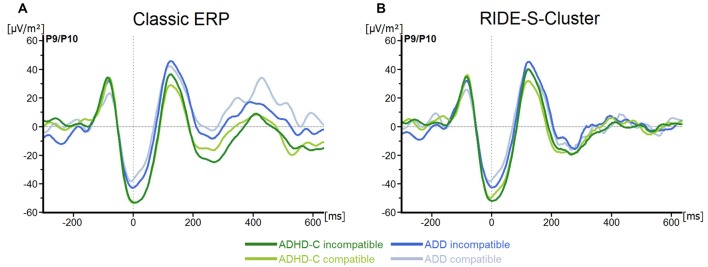
(A) Stimulus-locked waveforms (current source density, CSD) for P1Flanker, N1Flanker, P1Target, N1Target components and (B) the equivalent residue iteration decomposition (RIDE)-components (S-Cluster), depicted for both attention deficit/hyperactivity disorder (ADHD) subtypes and for compatible and incompatible flanker trials at electrodes P9/P10. Point 0 denotes the onset of the target stimulus.